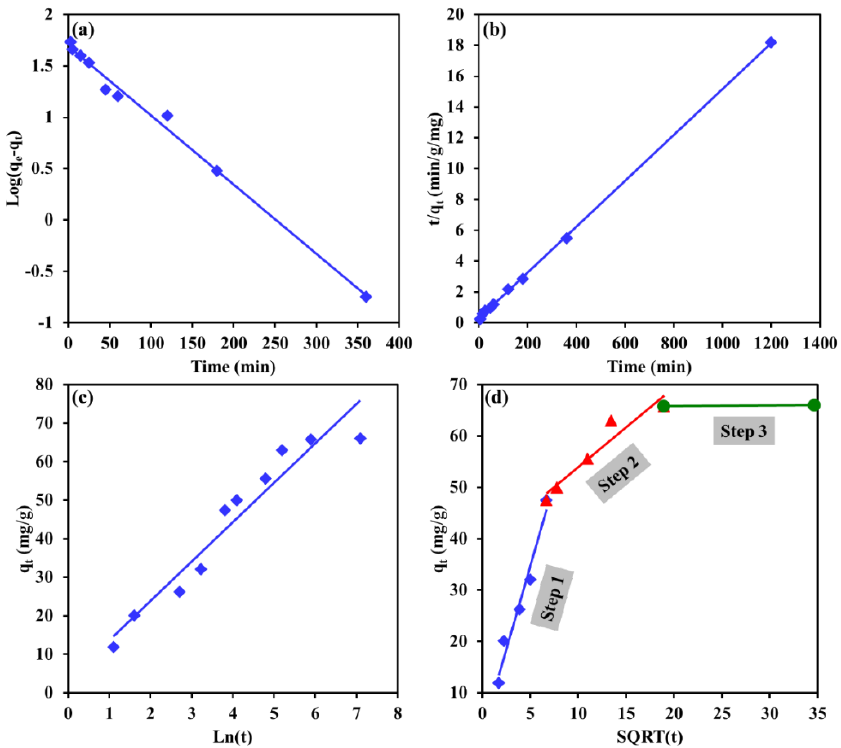
Figure 13. Linearized kinetic models fit of EBT dye removal by Mg-Ca-Al-LDO composite for ( a ) pseudo 1st order, ( b ) pseudo 2nd order, ( c ) Elovich and ( d ) intraparticle diffusion models.